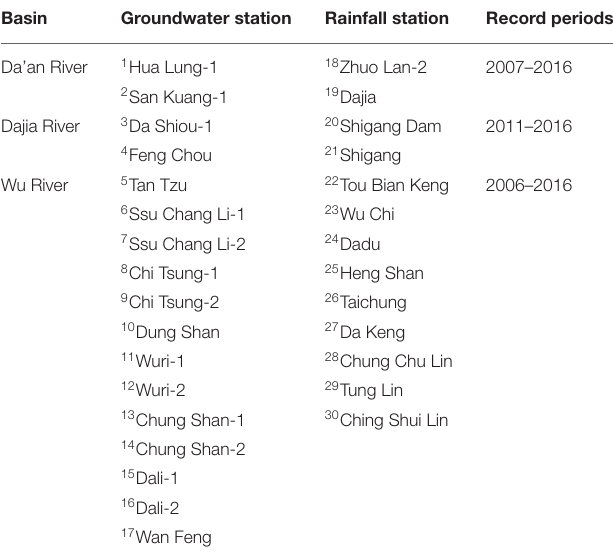
TABLE 2 | Information for the 13 rainfall stations and 17 groundwater